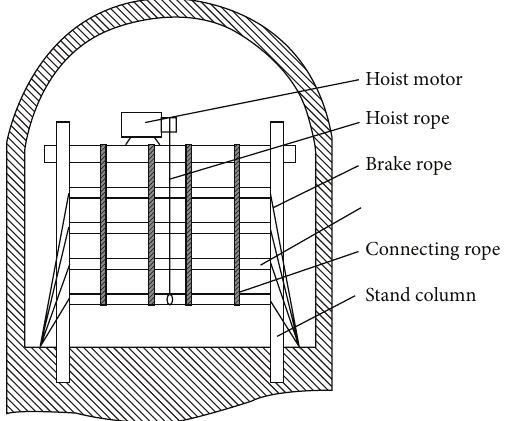
Figure 1: The intercepting door structure schematic drawing tramcar-hindering barrier.